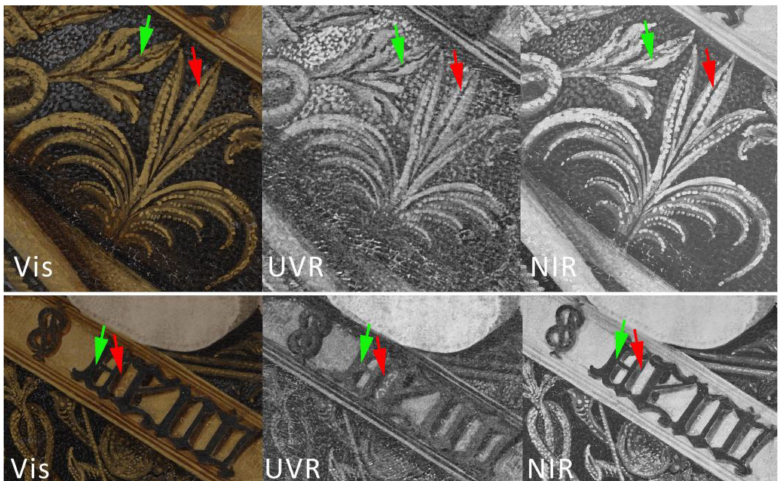
Figure 10. Comparison of pigments by means of UV-reflected and NIR-reflected. Hematite high- lighted with red arrow and carbon-based pigments highlighted with green arrow were used for the decorations, letters, and the shadows on the collar: both absorb UV radiation while hematite is transparent in the NIR